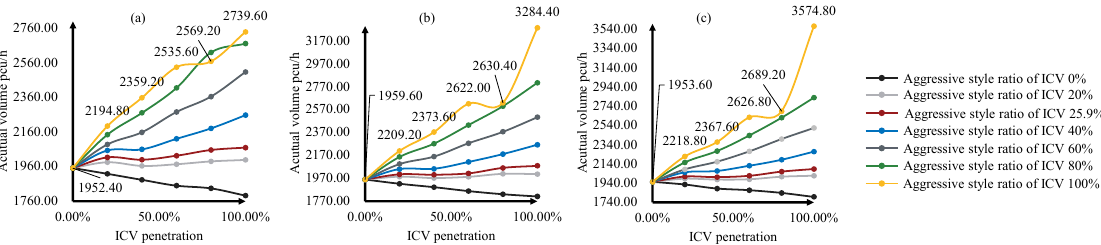
Figure 7. The impacts of SLADS on road capacity of the secondary motorway under different driving styles with the volume input being equal to the saturated service level ( a ), 20% oversaturated service level ( b ) and 40% oversaturated service level ( c ).